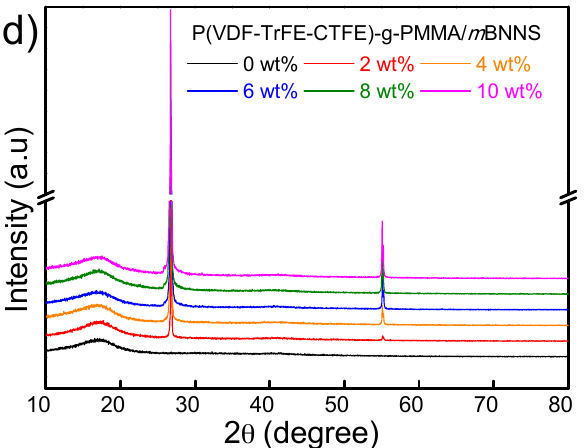
Figure 4. ( a , b ) FT-IR spectra and ( c , d ) XRD patterns for the composites containing varied BNNS and m BNNS particles, respectively.